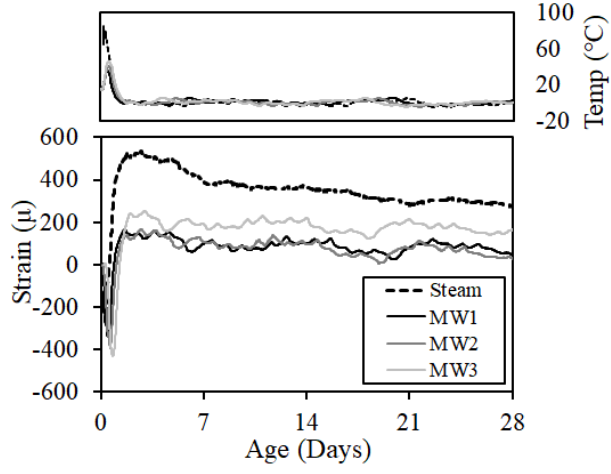
Figure 17. Free shrinkage.